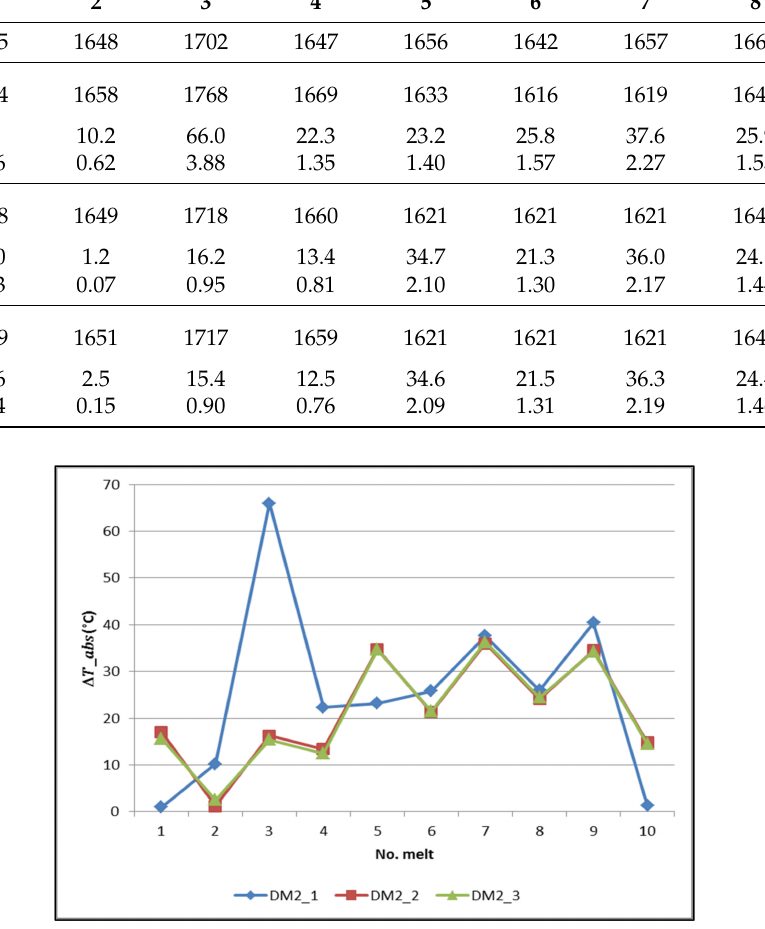
Figure 8. Absolute deviation of temperature for deterministic model without